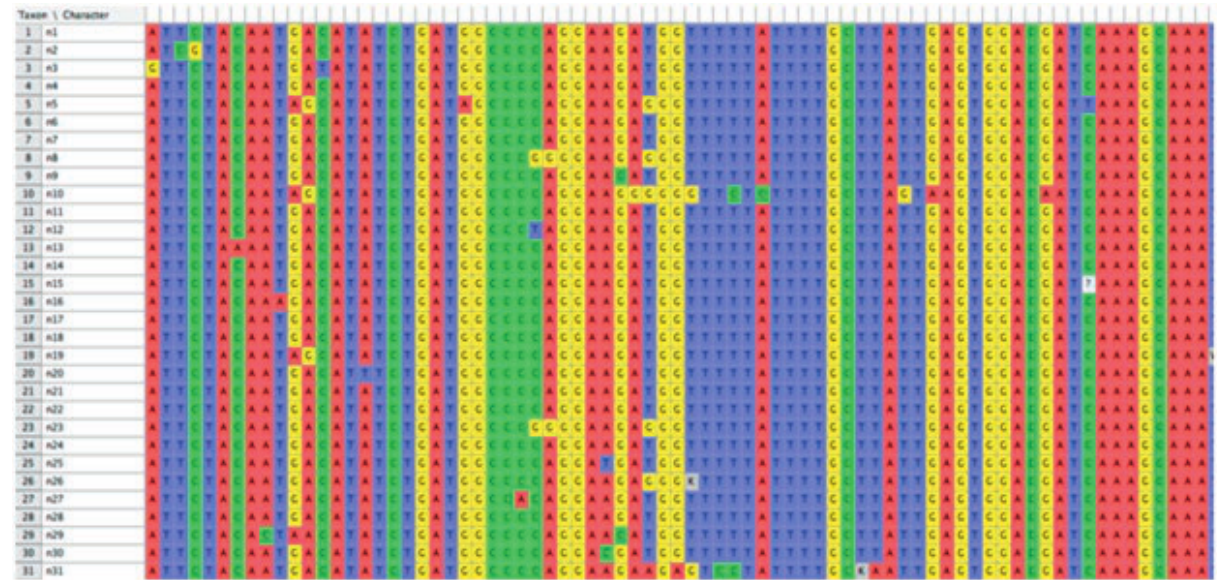
Figure 3. SNP diversity within TEXT-11 gene in the studied